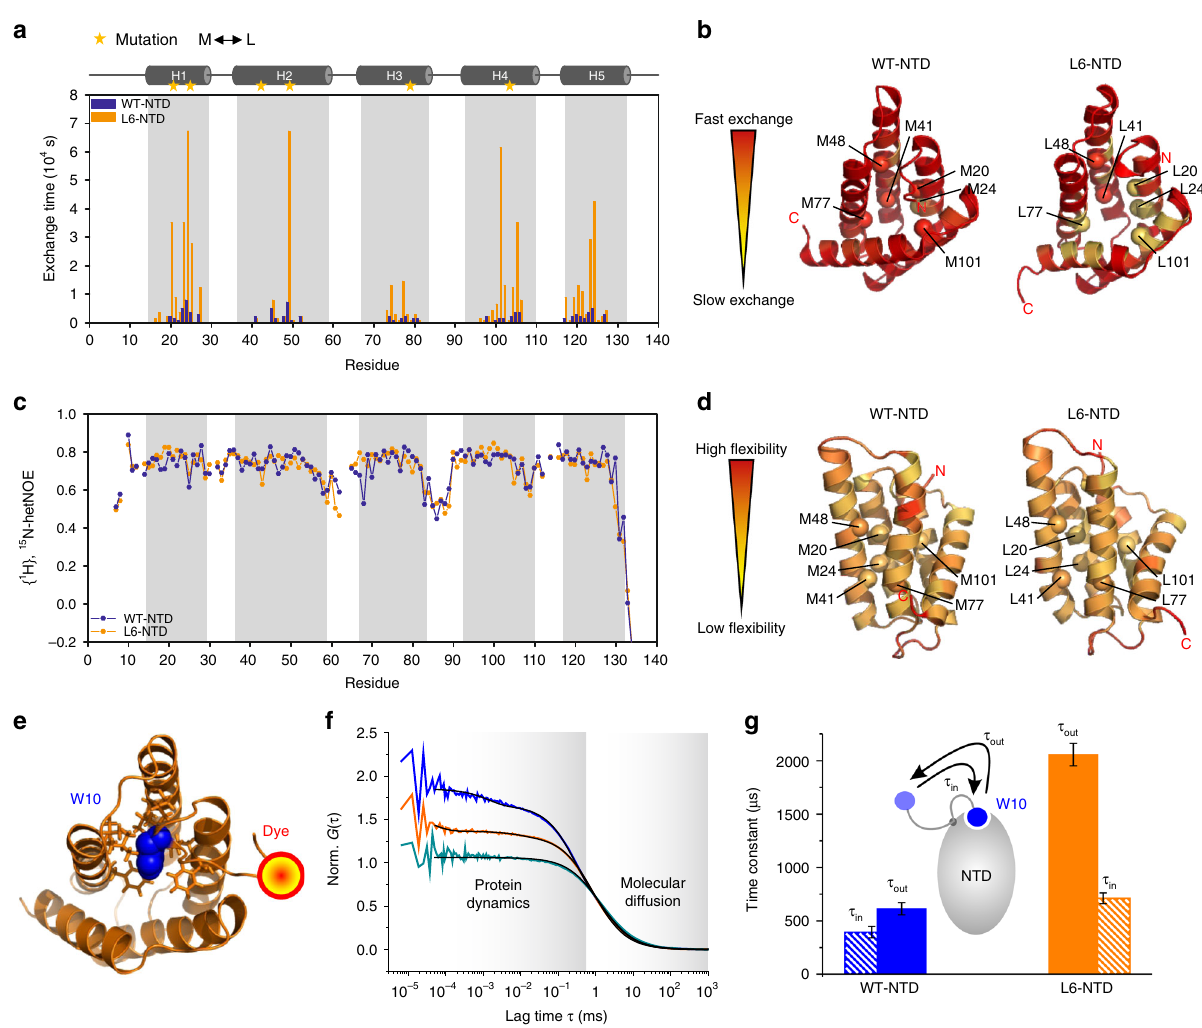
Fig. 6 Native-state dynamics of L6-NTD probed by NMR spectroscopy and PET-FCS. a NMR H/D exchange experiments. Amide H/D exchange time of L6- NTD (orange) and WT-NTD (blue) plotted versus residue number. Positions of helices and mutations are indicated on top of the panel. b Exchange times imposed on the structure of WT-NTD (PDB ID: 2LPJ) and of L6-NTD (PDB ID: 6QJY). c { 1 H}, 15 N-hetNOE values of WT-NTD (blue) and L6-NTD (orange) backbone amides plotted versus residue number. Lower values indicate higher fl exibility. d { 1 H}, 15 N-hetNOE values imposed on the structure of WT-NTD (PDB ID: 2LPJ) and L6-NTD (PDB ID: 6QJY), respectively. e Reporter design for PET-FCS. Top view of the structure of L6-NTD (PDB ID: 6QJY) indicating the position of the AttoOxa11 fl uorescence label (red sphere) attached to the N-terminus (G3C). The side chain of the conserved Trp W10 (blue sphere), which quenches fl uorescence of AttoOxa11 upon solvent-exposure, is highlighted. Trp is buried in a network of tertiary interactions (side chains shown as sticks). f PET-FCS autocorrelation functions ( G ( τ )) recorded from WT-NTD and L6-NTD (blue and orange) modi fi ed with AttoOxa11 at position G3C. Data of L6-NTD modi fi ed with AttoOxa11 at position Q50C served as a control (cyan). Black lines are fi ts to the data using a model for translational diffusion of a globule containing two single-exponential relaxations. The control sample was described by a model for translational diffusion only. g Time constants of Trp moving out of the core ( τ out , solid bars) and into the core ( τ in , patterned bars) of WT-NTD (blue) and L6-NTD (orange), calculated from PET-FCS data. Error bars are propagated s.e. from regression analysis. The comic at the center of the panel illustrates the conformational change and assigns τ out and τ in . The NTD is illustrated as gray ellipsoid. Trp W10 (blue sphere) moves between buried and solvent-exposed positions. Source data are provided as time constant τ 1 = 240 ± 17 µs and an amplitude a 1 = 0.64 ± 0.03 measured for WT-NTD, and τ 1 = 529 ± 19 µs and a 1 = 0.35 ± 0.01 measured for L6-NTD (±s.e. from regression analysis). The second kinetic phase had τ 2 = 2 ± 1 µs and a 2 = 0.19 ± 0.04 measured for WT-NTD; and τ 2 = 4 ± 1 µs and a 2 = 0.05 ± 0.01 measured for L6- NTD. The observed reduction of amplitude and increase of the mobility of W10 was reduced in L6-NTD compared to WT-